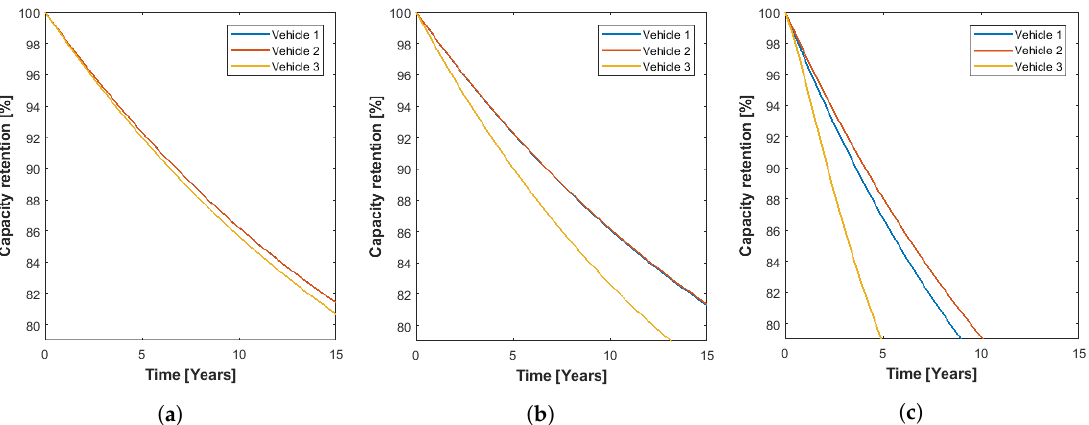
Figure 9. Ageing for the three vehicles while assuming driving according to, ( a ) WLTC medium; ( b ) WLTC; and ( c ) WLTC Extra High for five full charge/discharges per week all year around with a battery temperate of 30 ◦ C.